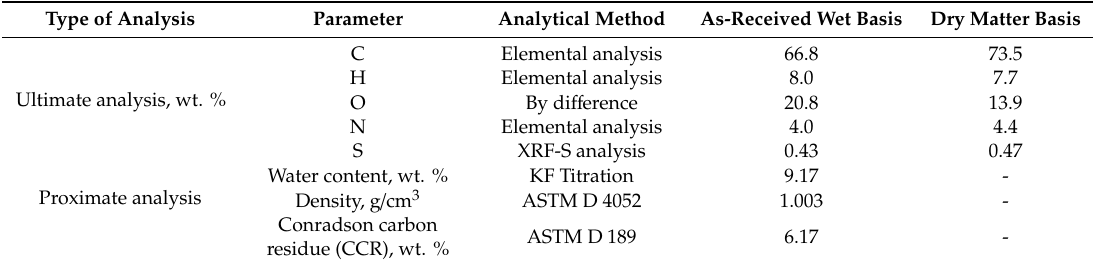
Table 1. Relevant properties of pyrolysis oil (Py-SS) obtained from sewage